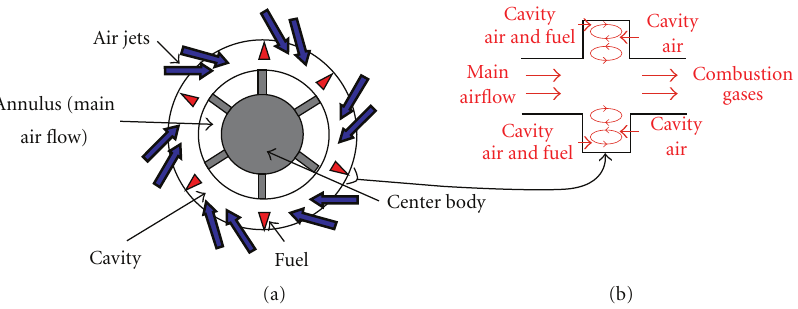
Figure 1: Cross-section of (a) UCC pictorial concept and (b) trapped vortex combustion [5].